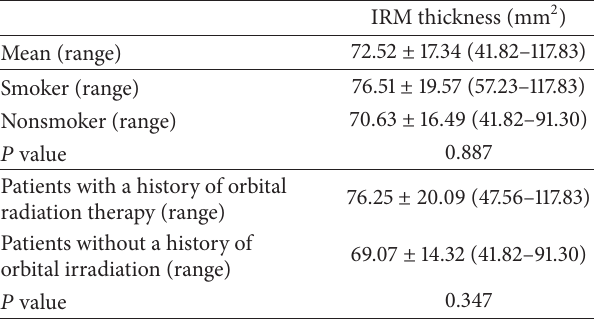
Table 2: Inferior rectus muscle thickness in each patient